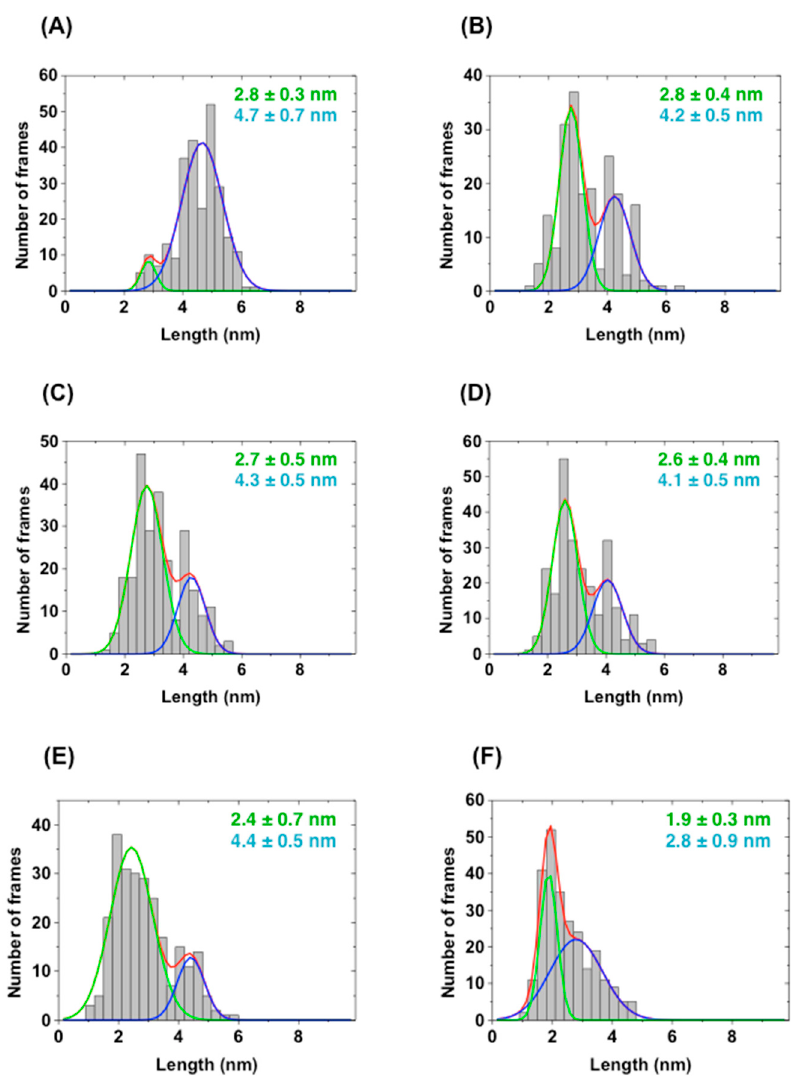
Figure 8. Histograms of the distances between the VH and VL domain. Histograms of the distances between the VH and VL domain were constructed from AFM images of AGE73scFv in the absence ( A ) and presence ( B ) of CBZ-GA-pyridine; 73MuL-V94A in the absence ( C ) and presence ( D ) of CBZ-GA-pyridine; and 73MuH19 in the absence ( E ) and presence ( F ) of CBZ-GA-pyridine. The distances between VH and VL domain were calculated by Origin software. The fitted distribution line for all scFv molecules (red), molecules with shorter distances (green), and molecules with longer distances (blue) are shown.